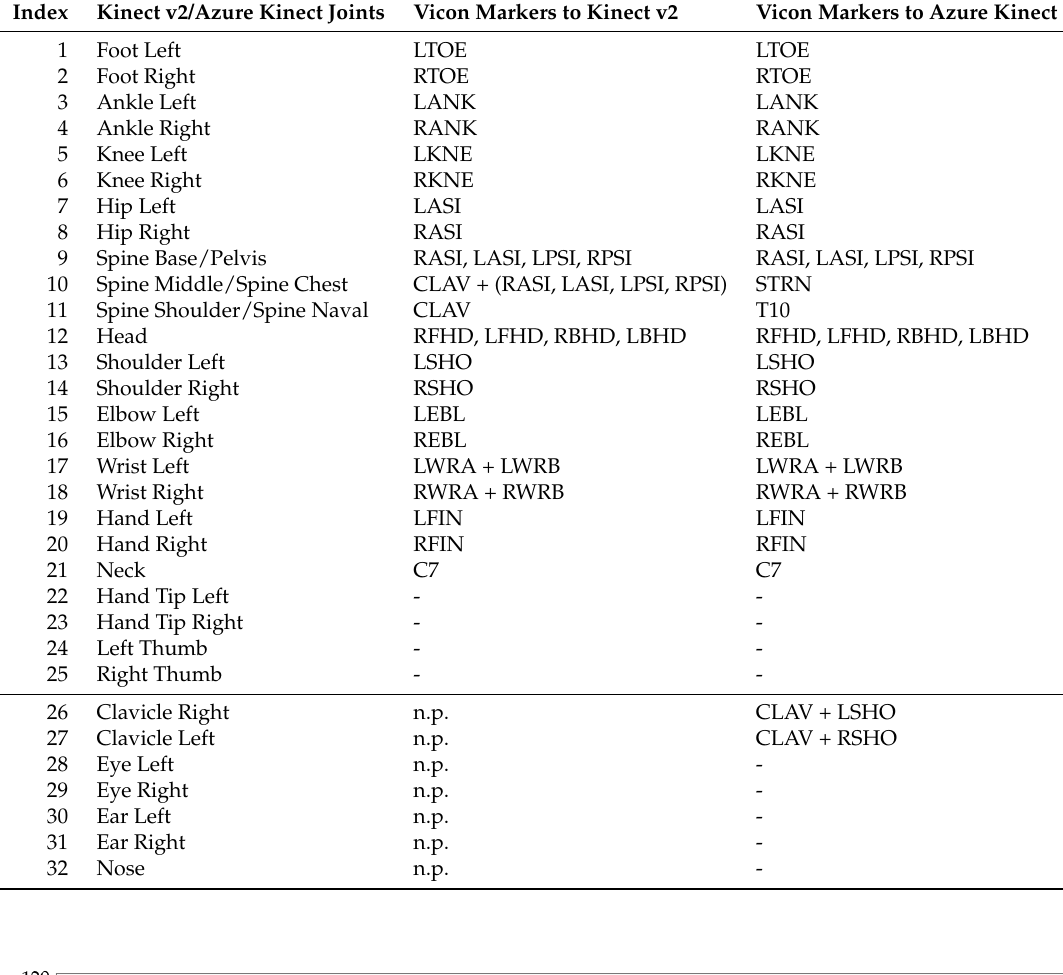
Table A1. Skeleton mapping of the 25 joints Kinect v2 and 32 joints Azure Kinect model to the 39 marker